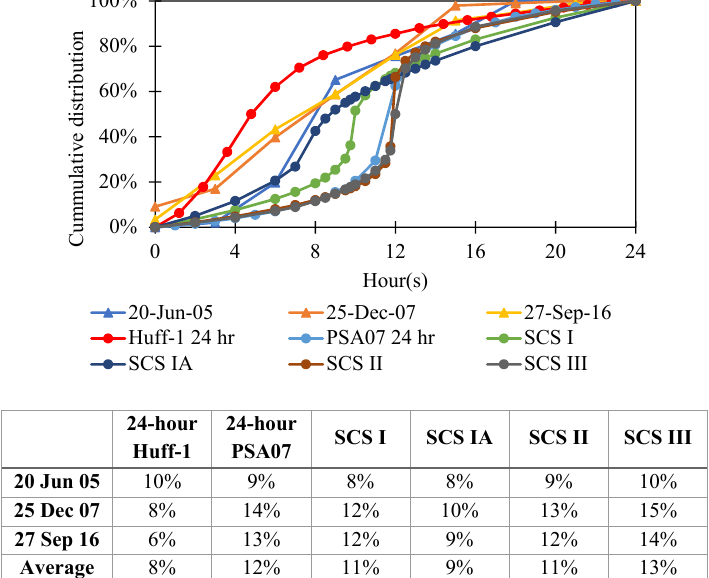
Figure 11. Comparison of rainfall distribution values and the average errors between 24-h Huff-1, 24-h PSA07, SCS I, SCS IA, SCS II, and SCS